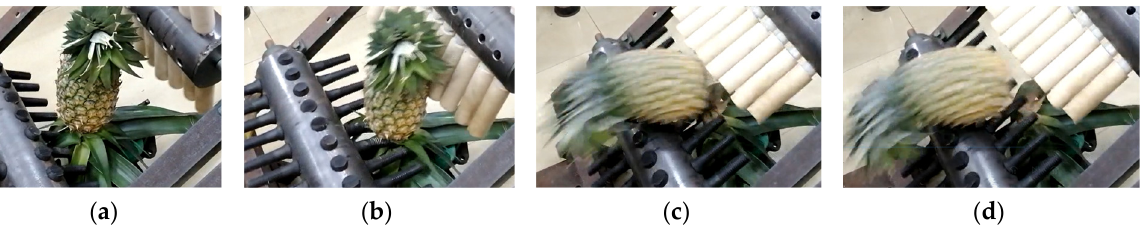
Figure 20. Some pictures of pineapple harvesting in a harvesting process. ( a ) Pineapple was located in the harvesting possibility area. ( b ) Left fingers contacted the pineapple. ( c ) Abscission layer was broken. ( d ) Pineapple fruit was detached from the plant.